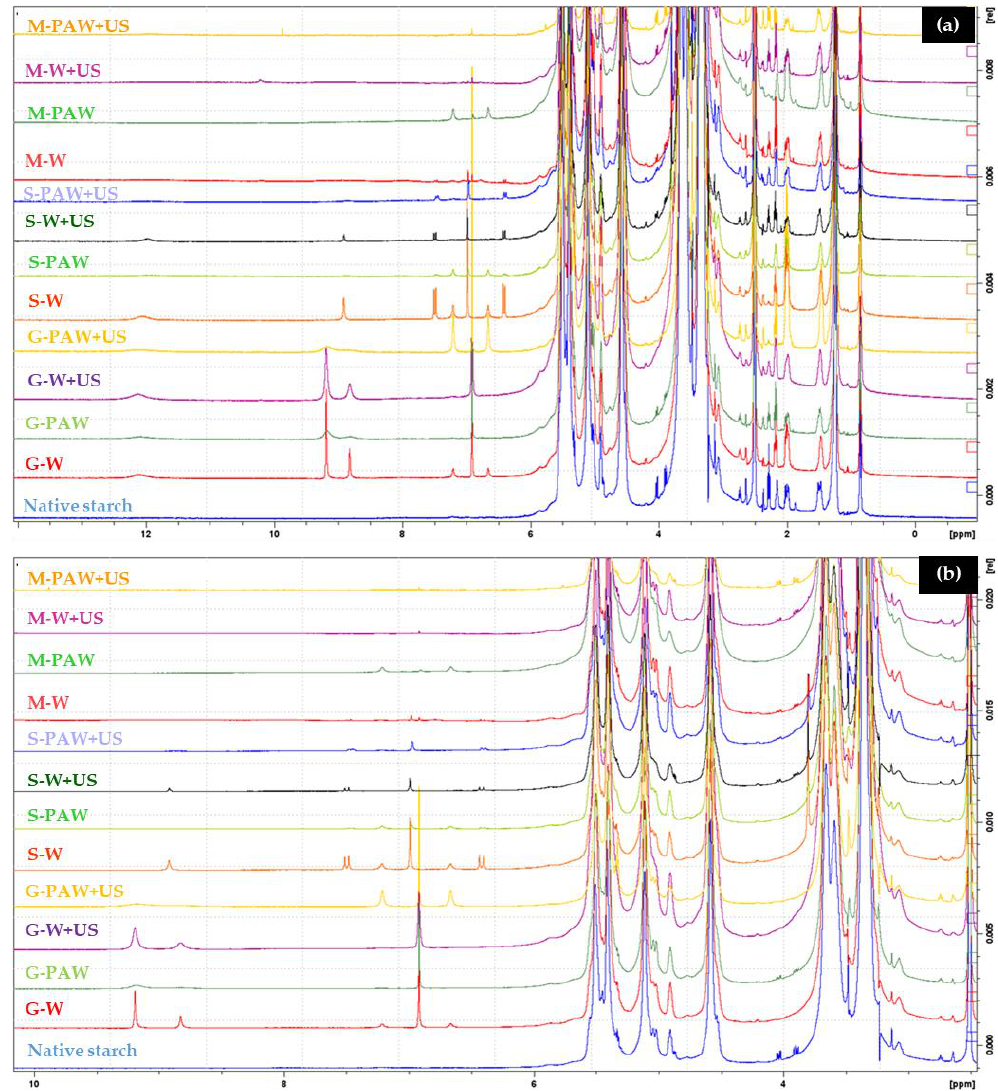
Figure 3. Representative 1 H NMR spectra of rice starch – phenolic complexes at 0 – 12 ppm ( a ) and 3 – 10 ppm ( b ). Different phenolic compounds — gallic acid (G), sinapic acid (S), and crude Mon-pu ( Glochidion wallichianum Muell Arg) (M) extract — were complexed with hydrothermally pre-gelatinized rice starch prepared using distilled water (W) or plasma-activated water (PAW) without and with the aid of ultrasonication (+US). The native starch was used to compare.